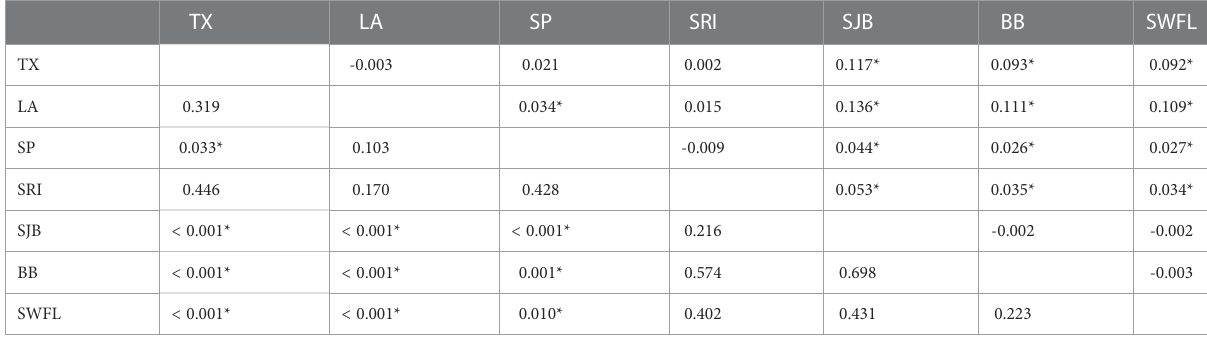
TABLE 2 Genetic structure among juvenile green turtle foraging aggregations in the Gulf of